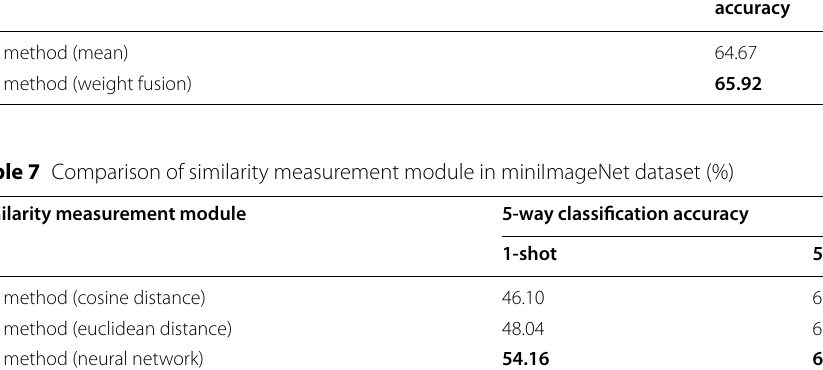
Table 6 Comparison of weight fusion module in miniImageNet dataset (%) Class-level feature characteristic